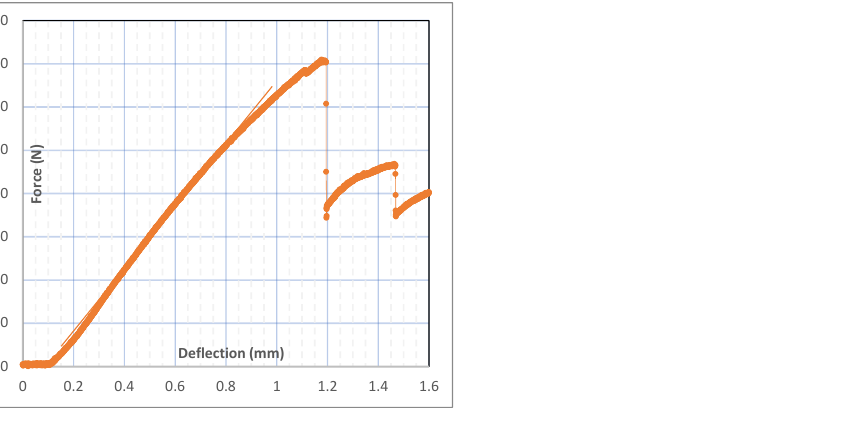
Figure 2. Sample force – deflection (3-point test); specimens in equilibrium conditions of T = 20 °C and H = 60%.